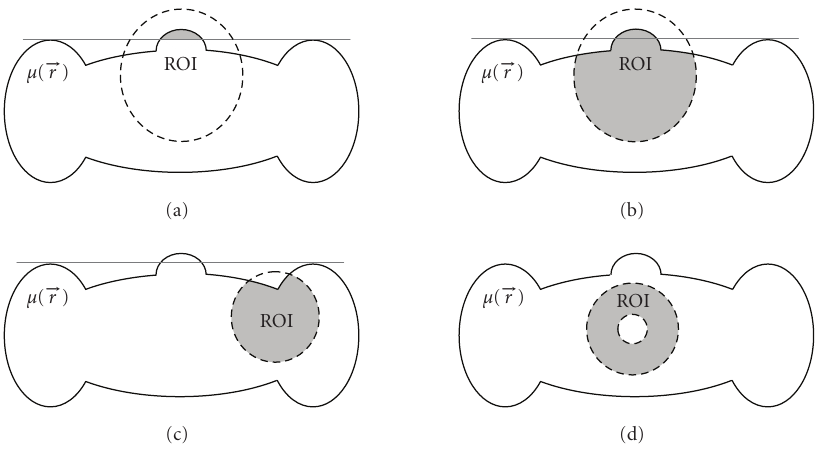
Figure 2: Circular field of view (FOV) and recoverable regions of interest (ROI) according to di ff erent data su ffi ciency conditions. (a) A small recoverable region per the condition by Noo et al., (b) the enlarged recoverable region per the condition by Defrise et al., (c) and (d) the recoverable region per our new data su ffi ciency condition when the FOV is contained in the convex hull of the compact support of the object and covers a part of known region. The dashed lines outline the FOV. The gray-region represents the recoverable ROI, where the exact reconstruction can be performed.